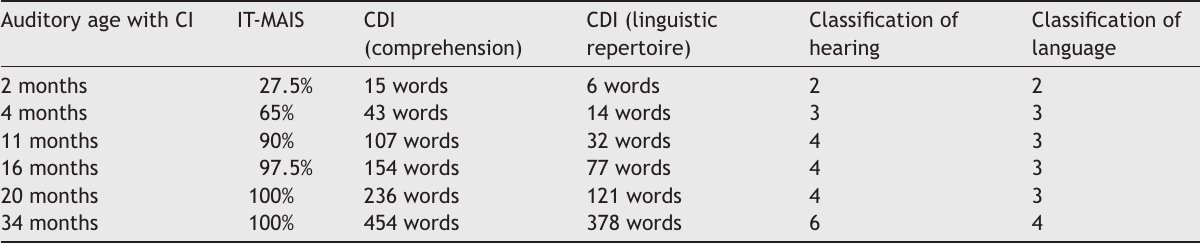
Table 8 Results of IT-MAIS and CDI tests and classifications of hearing and language of participant E. Auditory age with CI IT-MAIS CDI